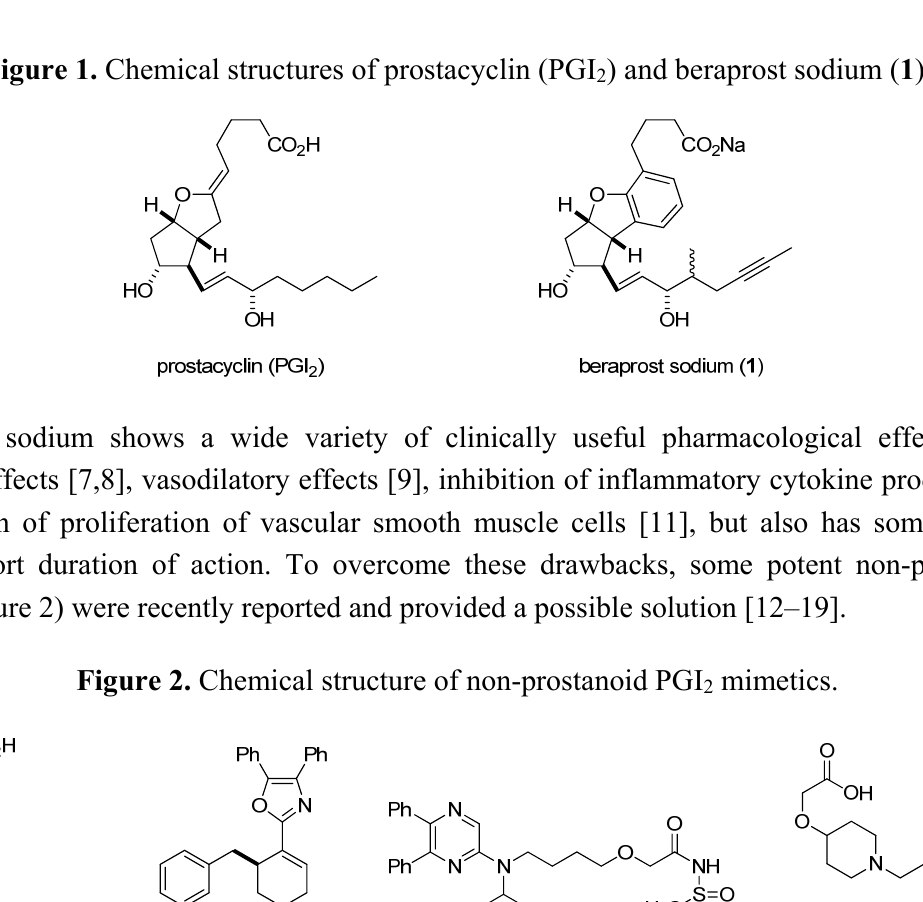
Figure 1. Chemical structures of prostacyclin (PGI